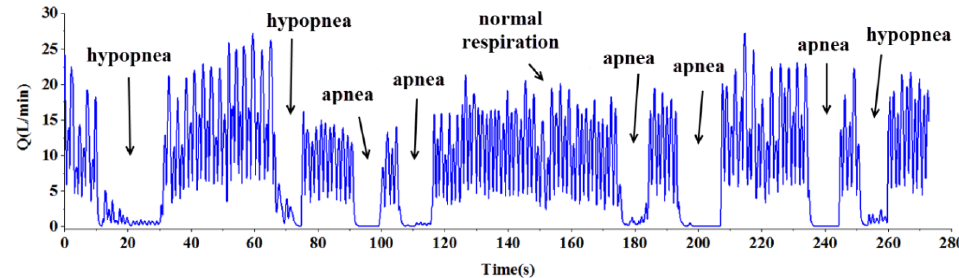
Figure 13. Apnea and hypopnea in real-time respiration signal.